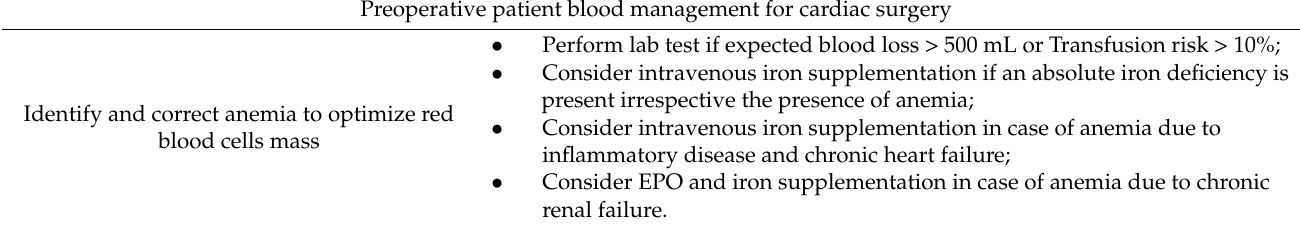
Table 1. Summary of our recommendation for preoperative, intraoperative and postoperative phases of Patient Blood management in cardiac surgery. Preoperative patient blood management for cardiac surgery